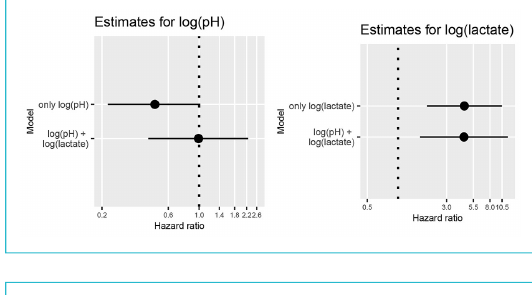
Figure 3: Confidence intervals of estimated hazard ratios of pH and lactate from univariate and multivariate models.